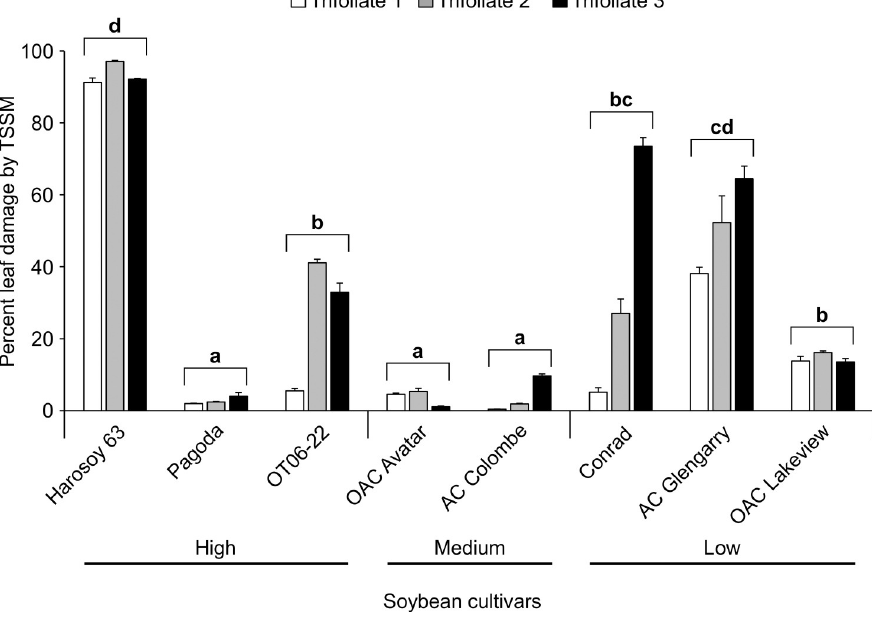
Fig 6. Leaf damage caused by two-spotted spider mite feeding to the top 3 trifoliate leaves of 8 soybean cultivars after 4 weeks. Data are mean ( ± S.E.) percent leaf damage. Bracketed bars with the same lower case letter are not statistically different (Kruskal-Wallis, Dunn’s test, P > 0.05).